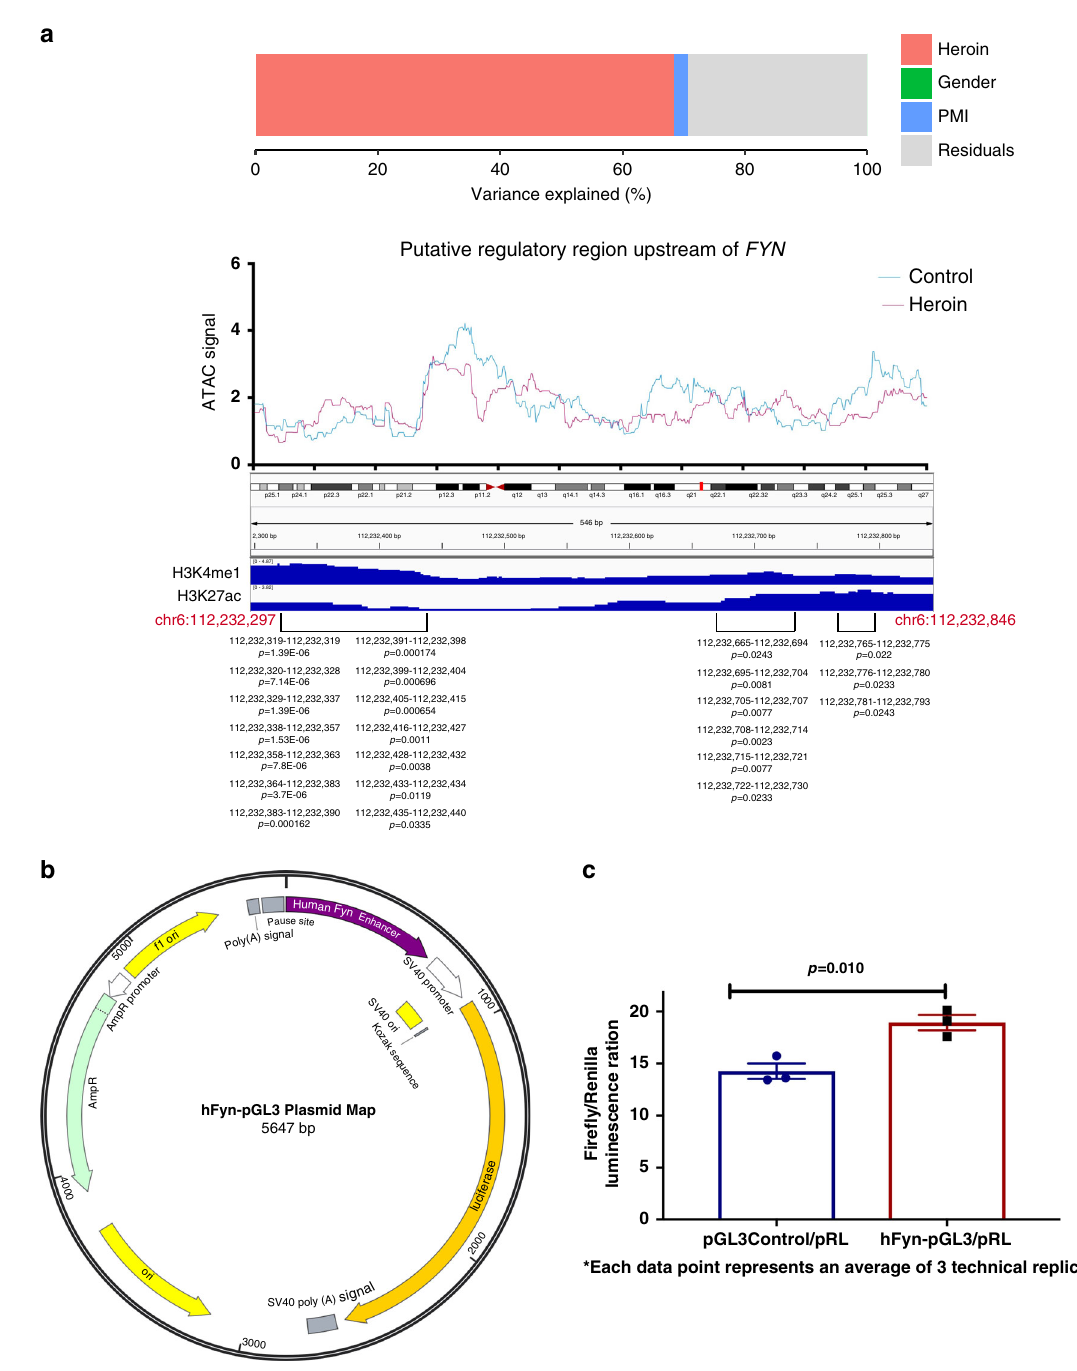
Fig. 3 Variance analysis of ATAC signal identi fi es a putative regulatory element upstream of FYN . a Variance distribution, raw ATAC signal, and enrichment of H3K4me1 and H3K27ac enhancer marks (ENCODE, human caudate nucleus; nominal signal p -values from ENCODE are shown) over the putative FYN regulatory locus. The contribution of heroin use to ATAC signal variance in this locus strongly exceeds that of other factors. H3K4me1 and H3K27ac are signi fi cantly enriched in this region, suggesting it might be an active enhancer b hFyn-pGL3 reporter plasmid map. c Dual-glo luciferase assay in HEK293 cells revealed signi fi cantly increased luciferase activity in cells transfected with hFyn-pGL3 compared to pGL3 control vector ( n = 3/group, Student ’ s t -test, t 4 = 4.505, p = 0.0108). Data are represented as mean ± SEM. Source data are provided as a Source Data fi